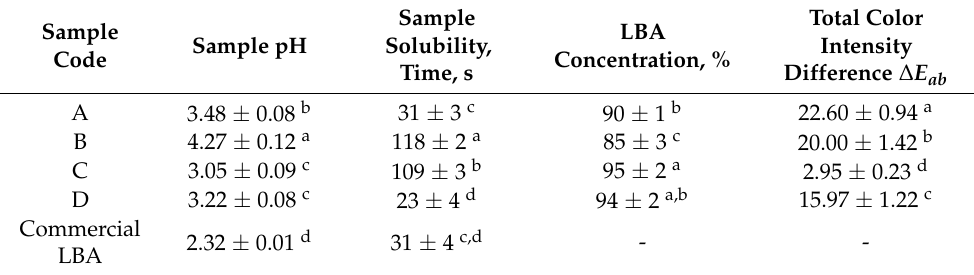
Table 3. LBA samples pH, solubility, concentration and total color intensity